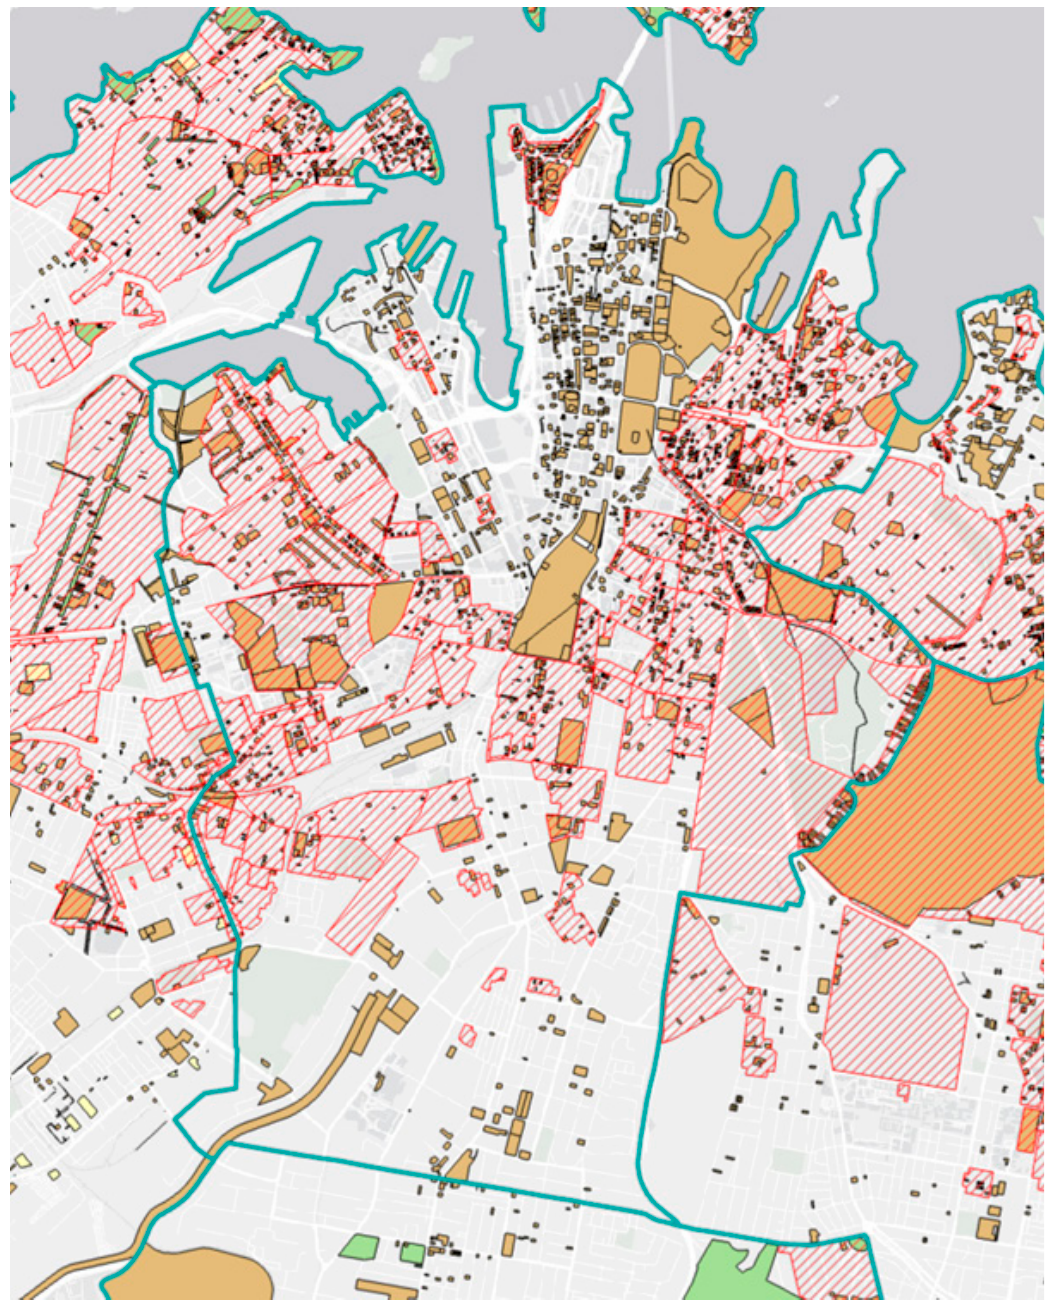
Figure 23. Sydney LEP heritage mapping (https://www.planningportal.nsw.gov.au/spatialviewer/#/find-a-property/address).